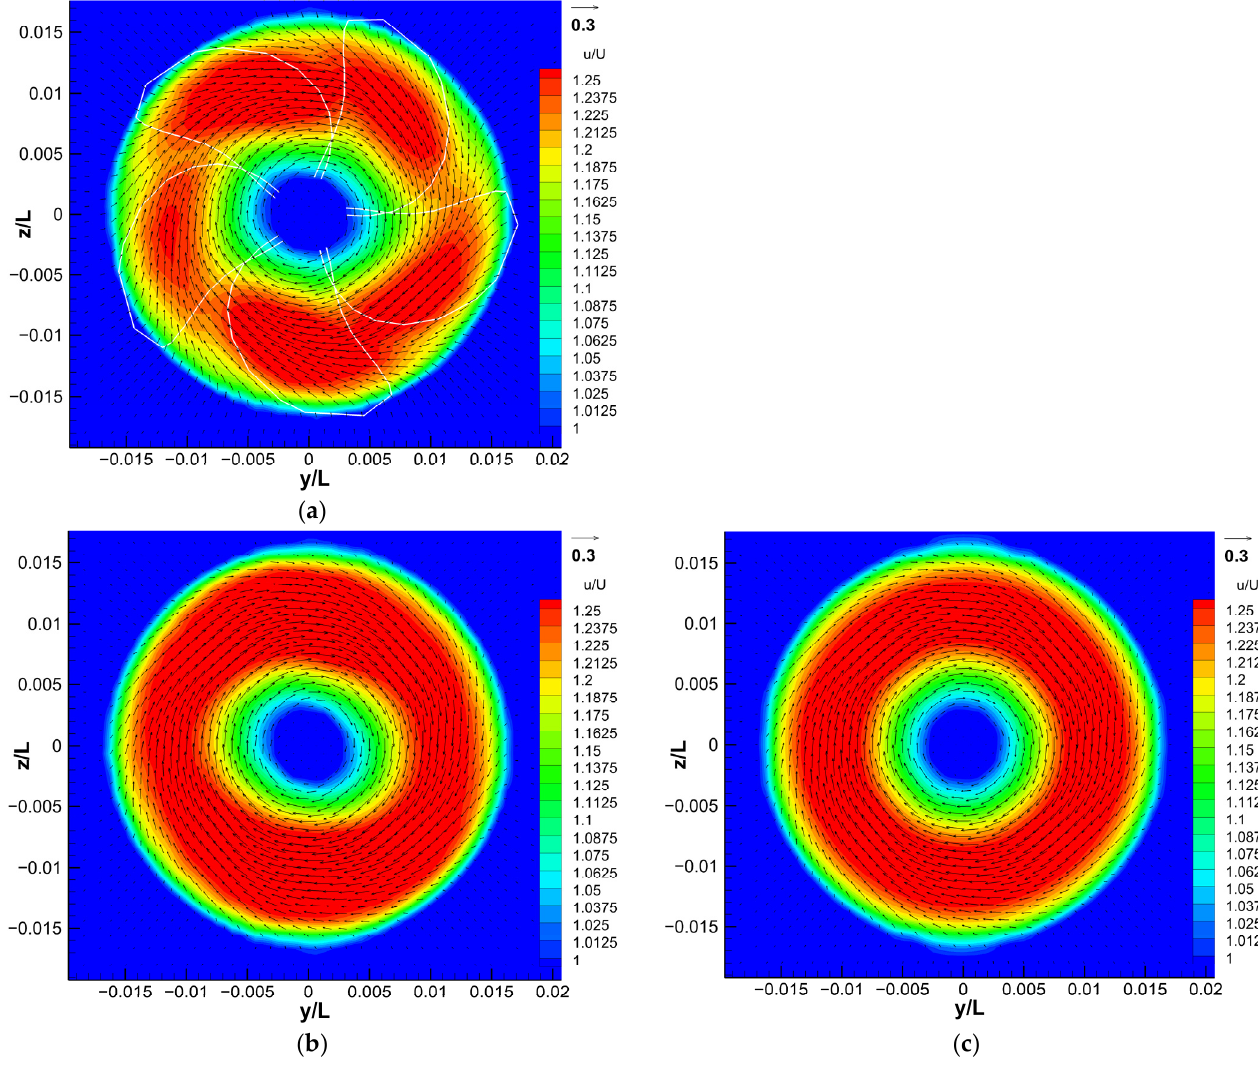
Figure 10. Propeller wake flow field: ( a ) rotating blade model (on x/L = 0.005 plane behind the propeller); ( b ) rotating blade model (on x/L = 0.01 plane behind the propeller); ( c ) average model (on x/L = 0.005 plane behind the propeller). Here, x/L = 0 is at the propeller center.